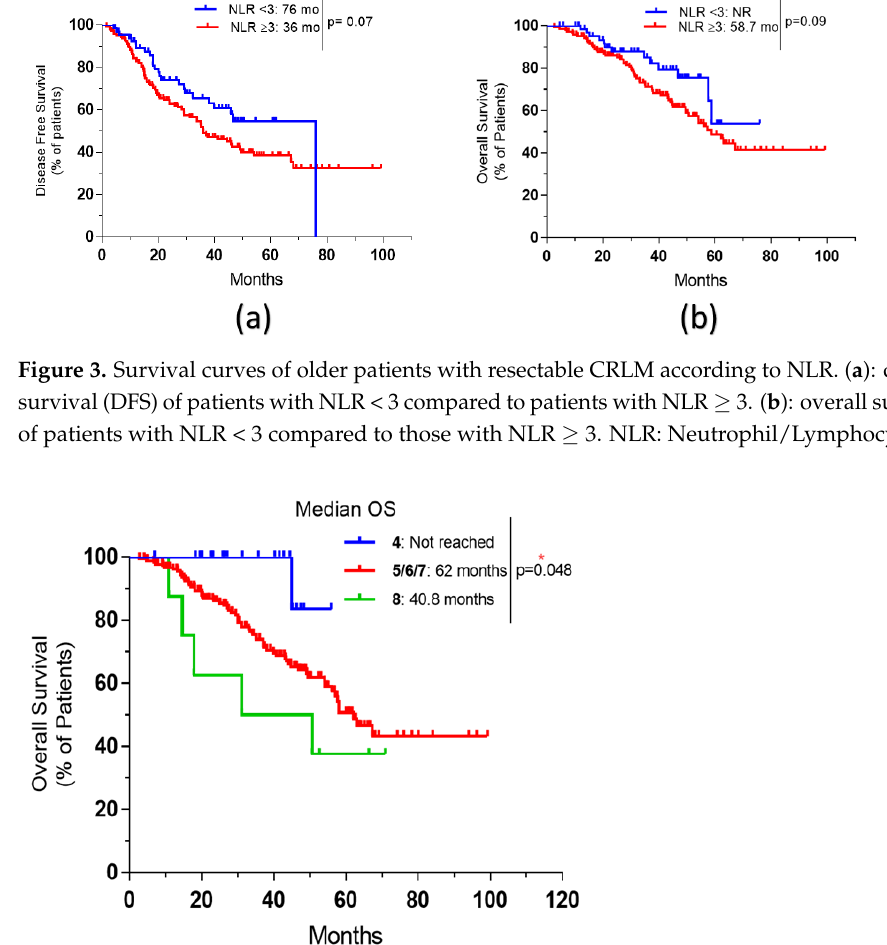
Figure 4. Overall survival for patients with resectable CRLM according to CCI groups. Patients were divided to three groups: CCI of 4 vs. CCI of 5, 6 and 7 vs. CCI of 8. CCI: Charlson comorbidity Score; *: significant p -value.